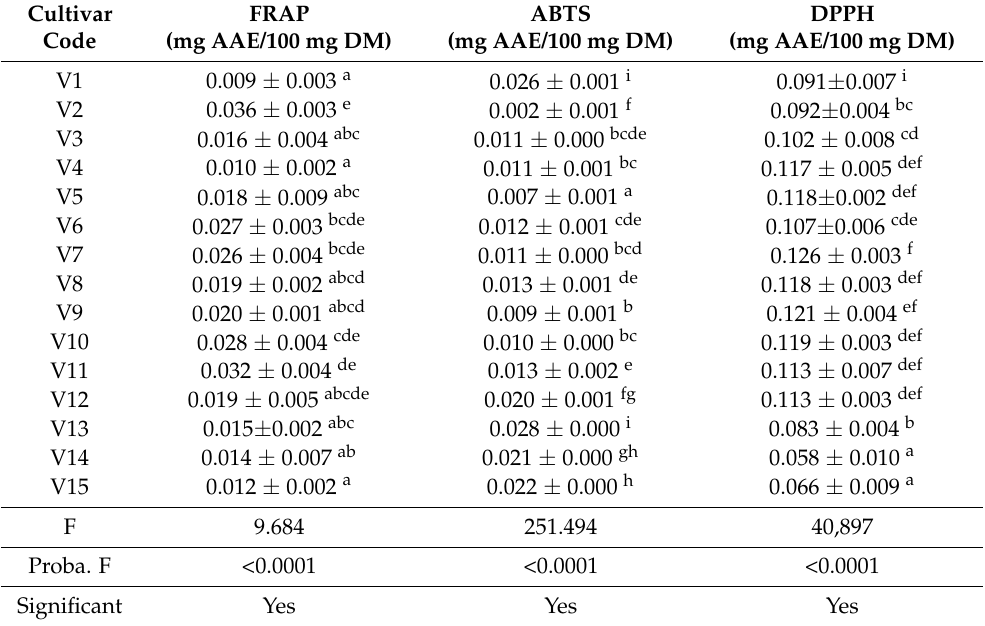
Table 4. Antioxidant activities of sorghum